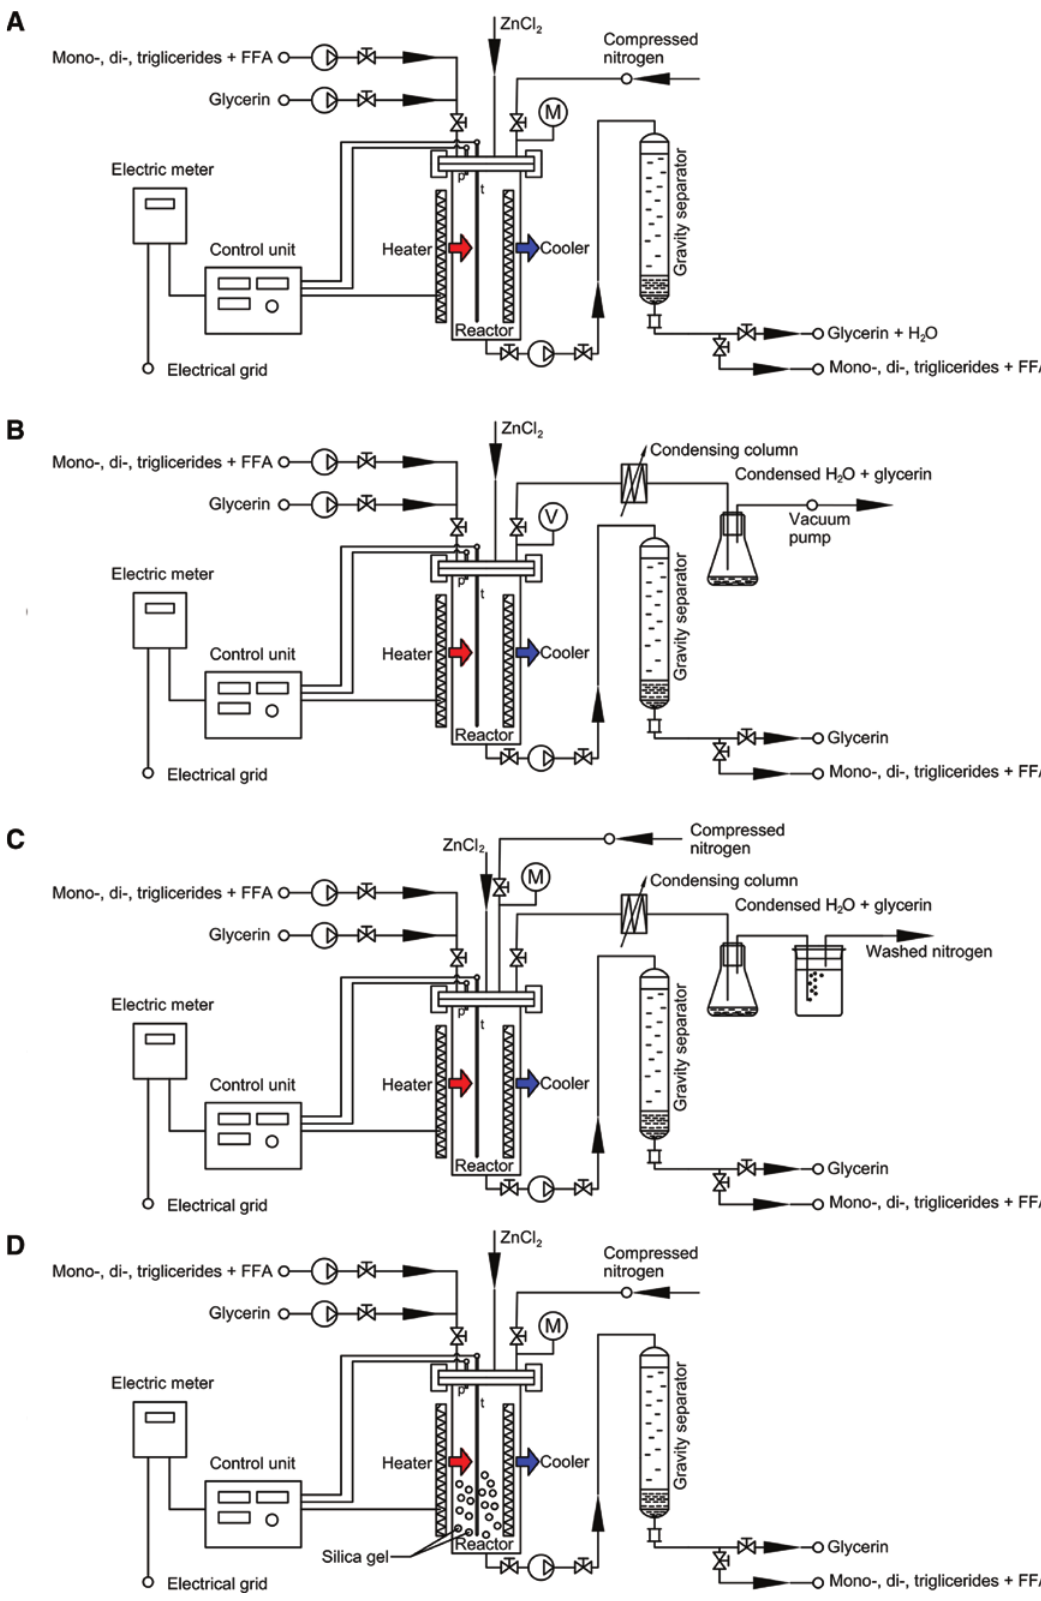
Figure 1: Different experimental set-up and water removal strategies: (A) without removing water, (B) vacuum distillation, (C) drying with nitrogen as sweep gas and (D) using silica gel as